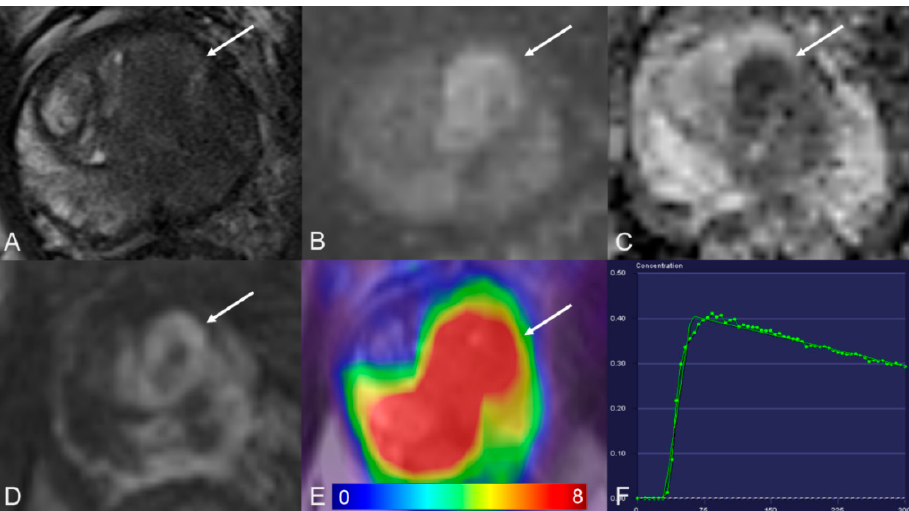
Figure 2. Transition zone with a PI-RADS 5 lesion. ( A ) Axial T2WI shows homogeneous hypointense. ( B ) DWI (b = 1000 s/mm 2 ) shows a marked hyperintense signal above the background. ( C ) ADC map image presents a lesion with hypointense signal below the background. ( D ) Early dynamic contrast-enhanced image presents positive enhancement within the lesion. ( E ) [ 68 Ga]Ga-PSMA-11 PET/MRI fusion image shows avid [ 68 Ga]Ga-PSMA-11 uptake, with SUVmax of 29.2. ( F ) DCE-MRI time-intensity curve demonstrates a decline after initial up-slope enhancement. AT: 0.47 min; TTP: 0.50 min; W-in: 0.80; W-out: − 0.03; PEI: 0.41; iAUC: 0.31.